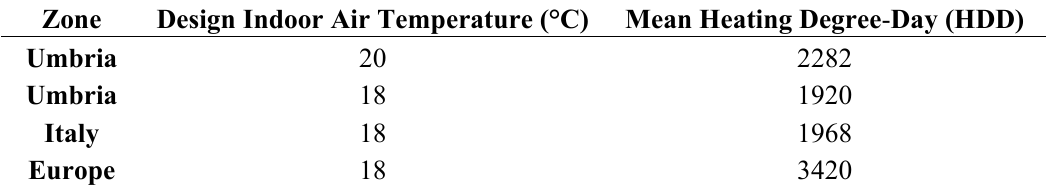
Table 1. Mean Heating Degree-Day for Umbria, Italy and